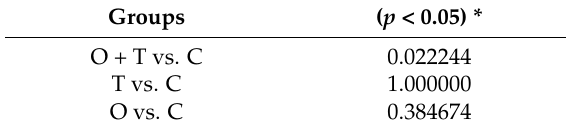
Table 4. Mann-Whitney post-hoc statistical test for the MSCs (CD44H/CD54/CD45/CD34).